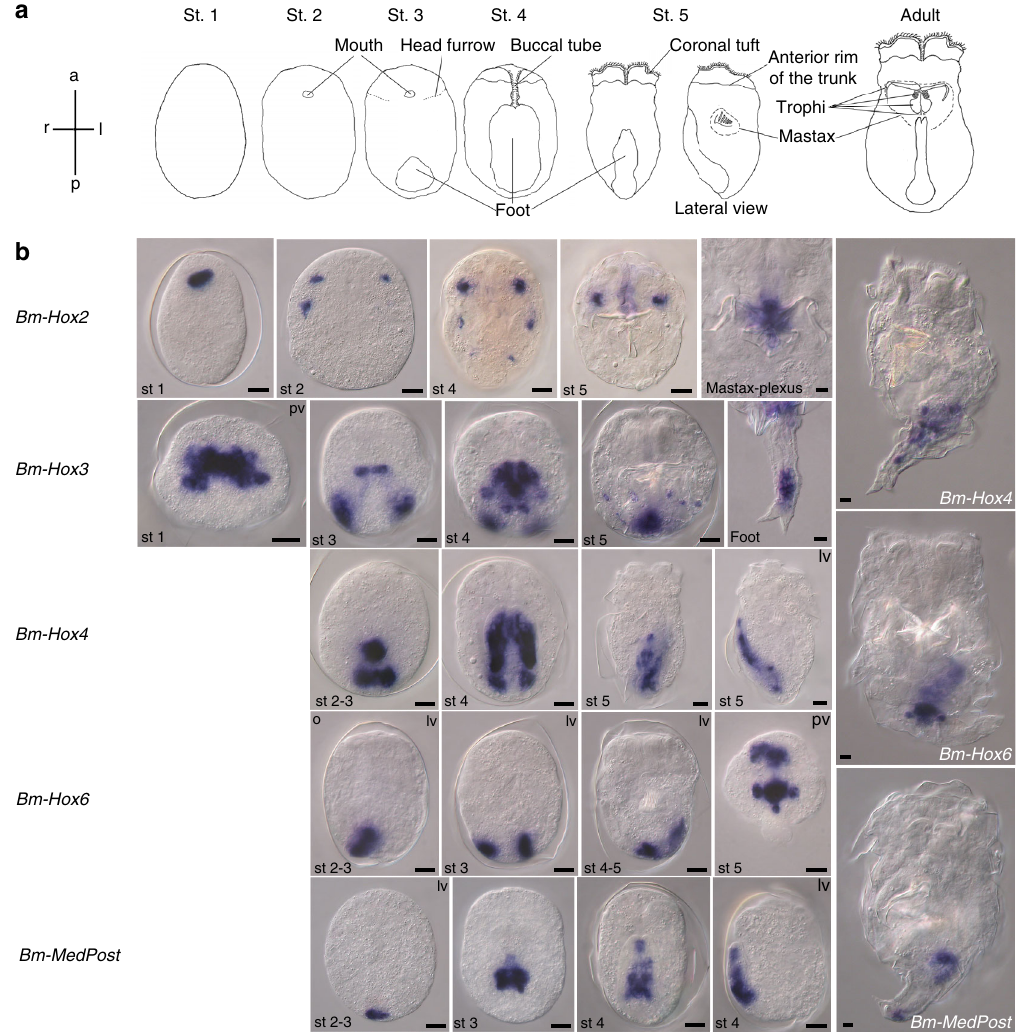
Fig. 2 Expression of Hox genes during embryogenesis of Brachionus manjavacas . a Schematic of embryonic stages of Brachionus manjavacas with morphological characteristics used for staging. b Whole-mount in situ hybridization on amictic female embryos. Adults are only shown for genes with expression persisting into the adult stage. Anterior to the top. Mostly ventral views are shown. pv, posterior view, dorsal side up; lv, lateral view, ventral to the left. Scale bar, 10 µ three interconnected neurons each (Fig. 2 and Supplementary